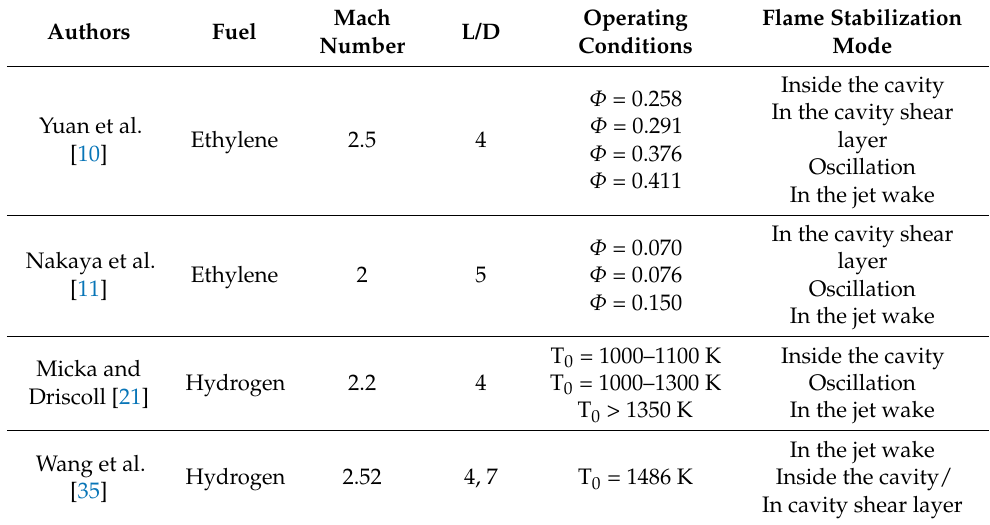
Table 2. Flame stabilization modes previously investigated and reported in the literature.